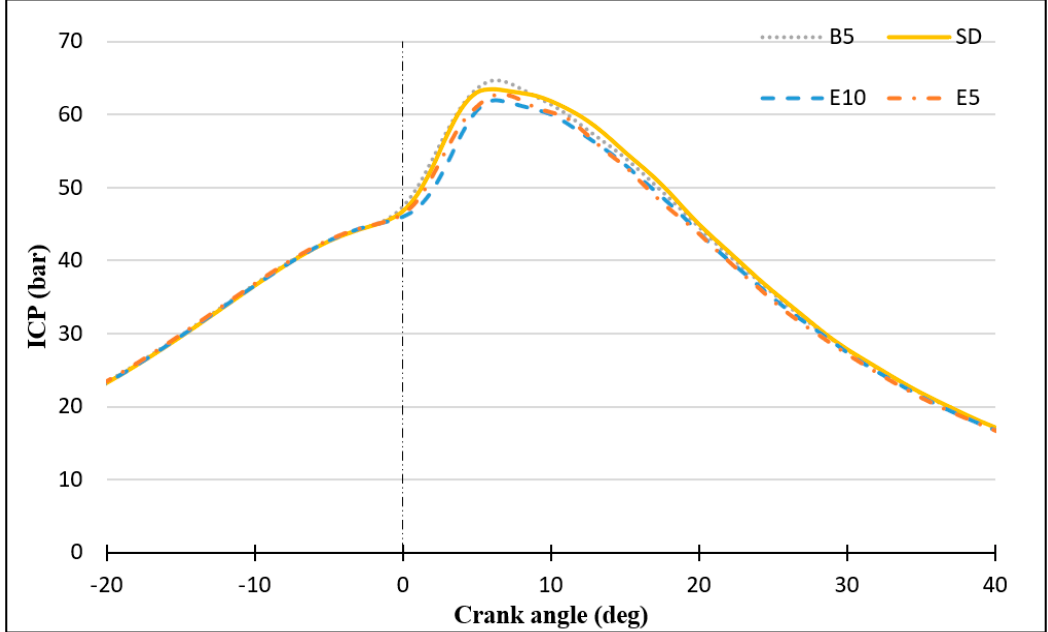
Figure 12. In-cylinder pressure traces for B5, E10, E5, and SD at 4 kW.